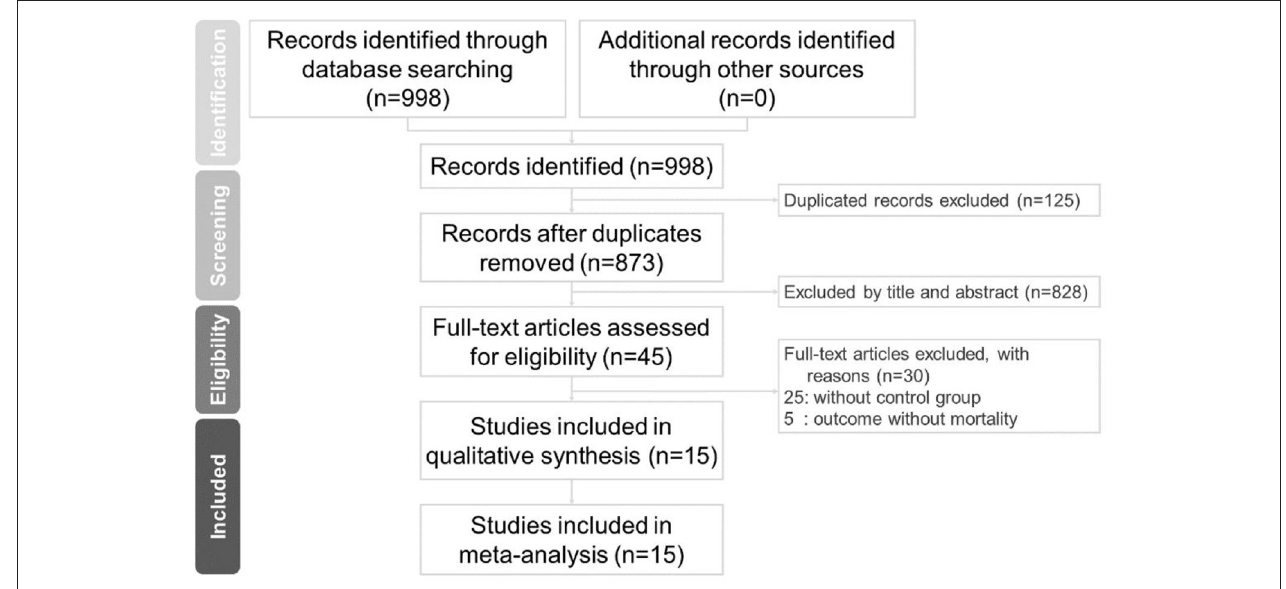
FIGURE 1 | Preferred Reporting Items for Systematic and Meta-Analyses (PRISMA) study flow